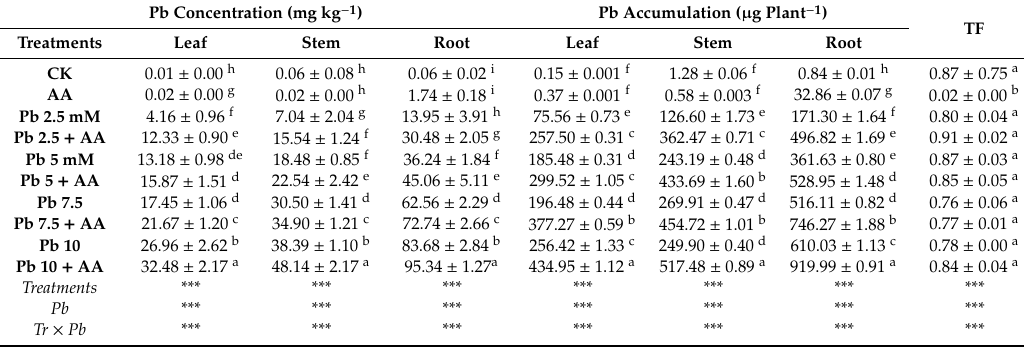
Table 3. E ff ect of Pb (0, 2.5, 5, 7.5 and 10 mM) with and without AA (2.5 mM) on Pb concentration, accumulation and root-shoot translocation factor (TF) in A. bettzickiana